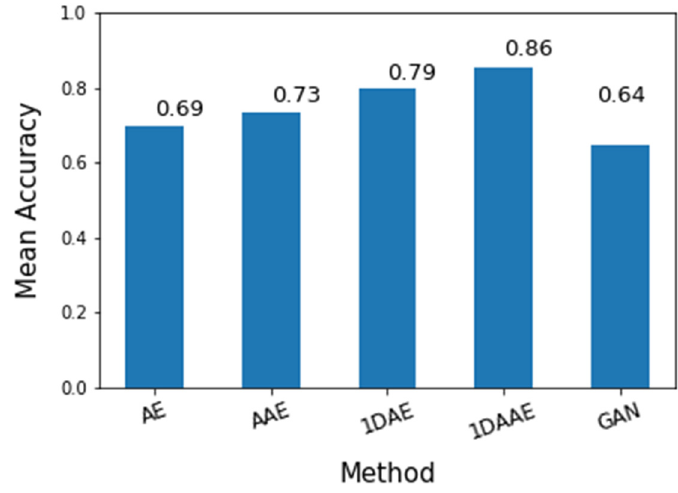
Figure 15. The mean accuracy based on the AE, AAE, 1DAE, GAN, and 1DAAE.